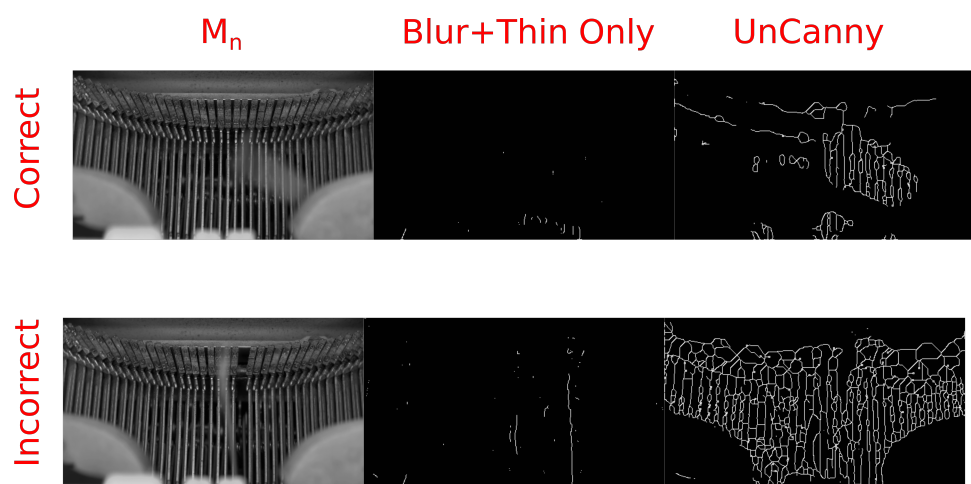
Figure 6. This figure shows examples of correct and incorrect motion identification by the UnCanny filter due to background vibration. In the correct example, the UnCanny method without edge detection (“Blur + Thin Only”) and with edge detection identify similar regions where the striker of the typewriter is moving. In the incorrect example, vibrations caused by the ribbon carrier progression (the blurred cylinders in the bottom of each input image) cause the UnCanny filter to report that the entire set of at-rest strikers is moving, rather than the single striker in motion near the